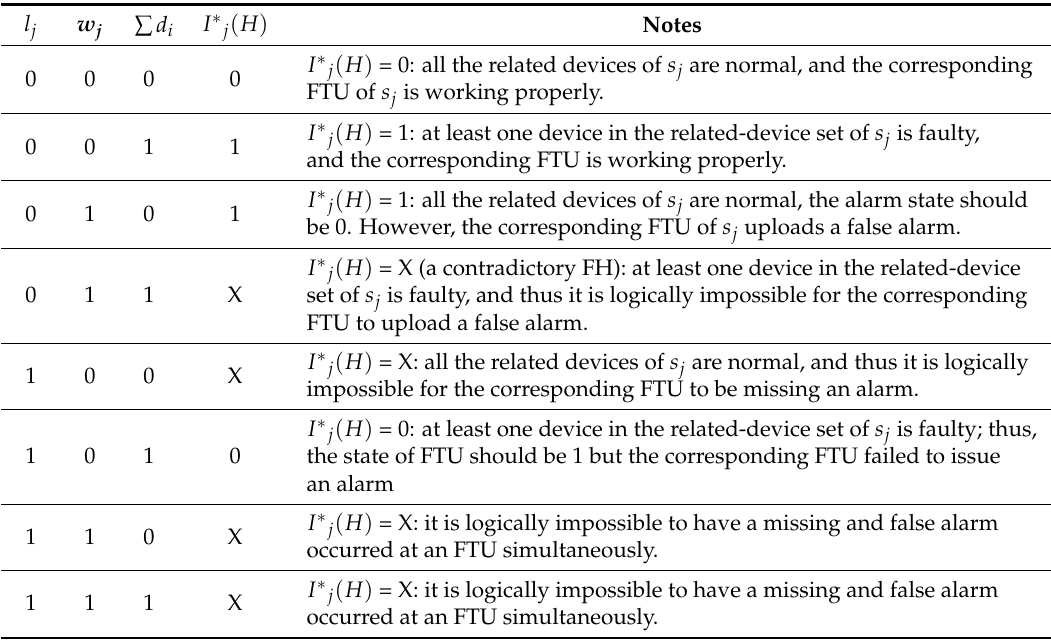
Table 2. The truth table of actual states of